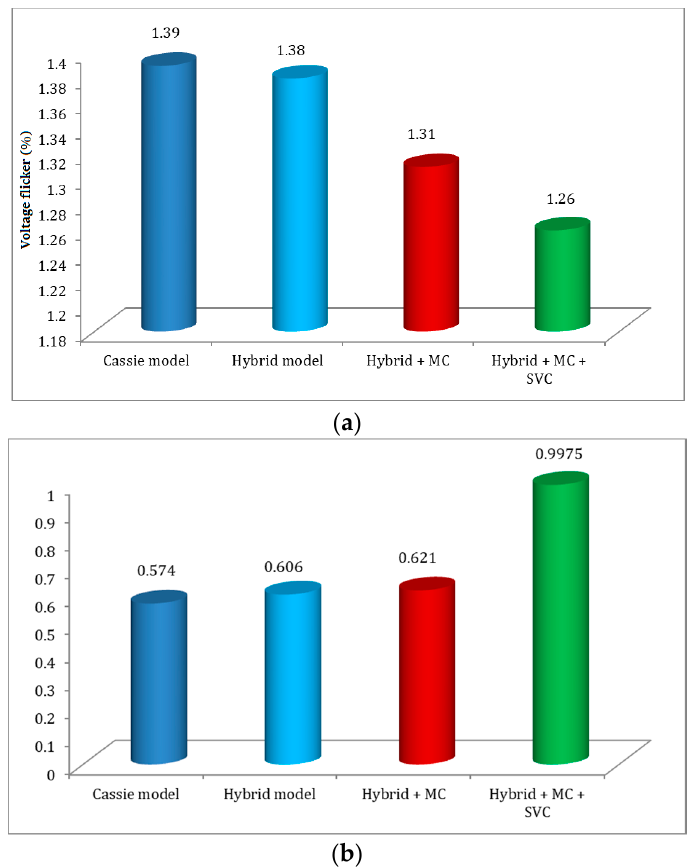
Figure 17. ( a ) Voltage flicker in % ( b ) Power factor.